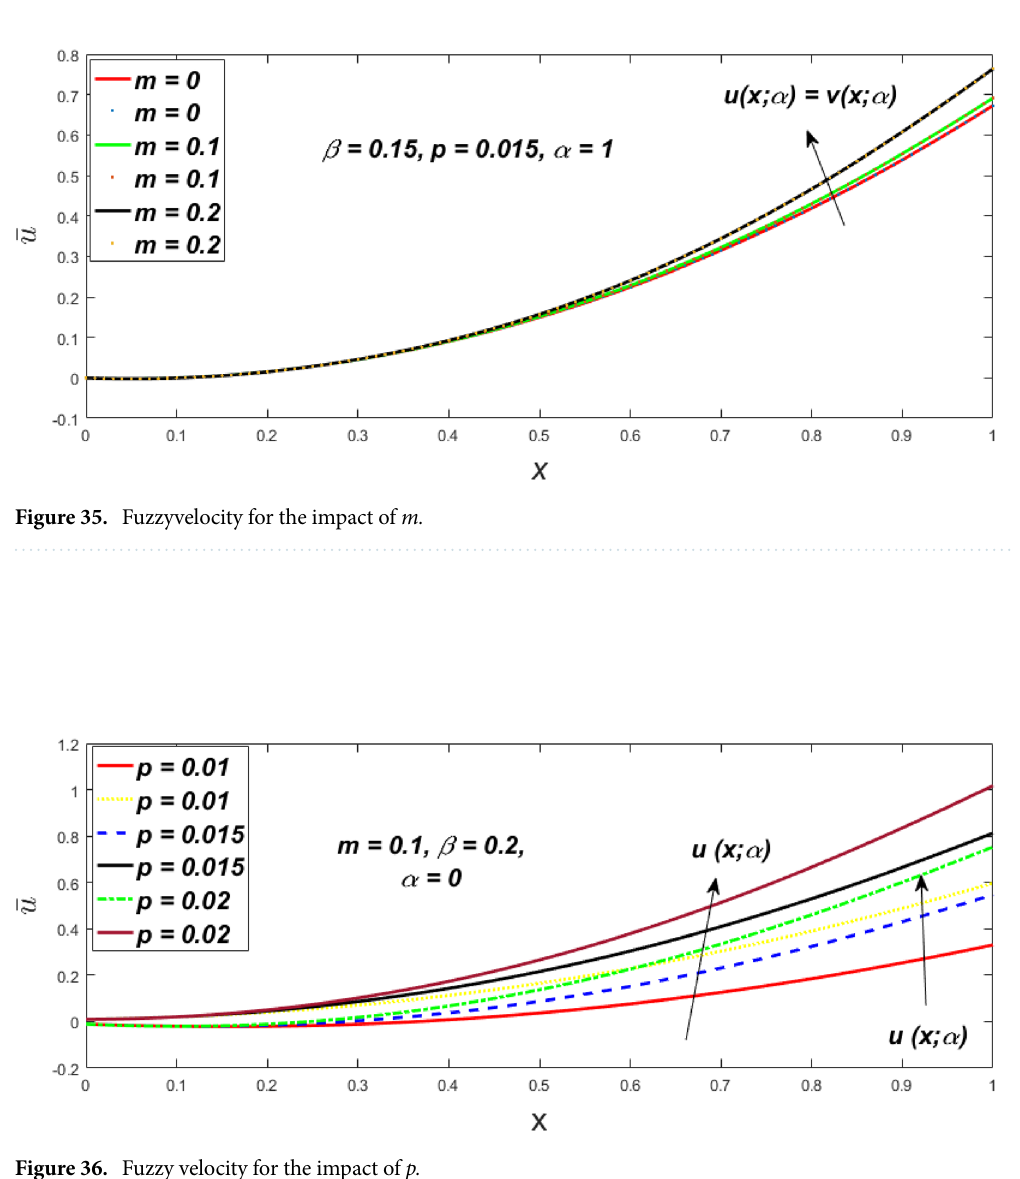
Figure 36. Fuzzy velocity for the impact of